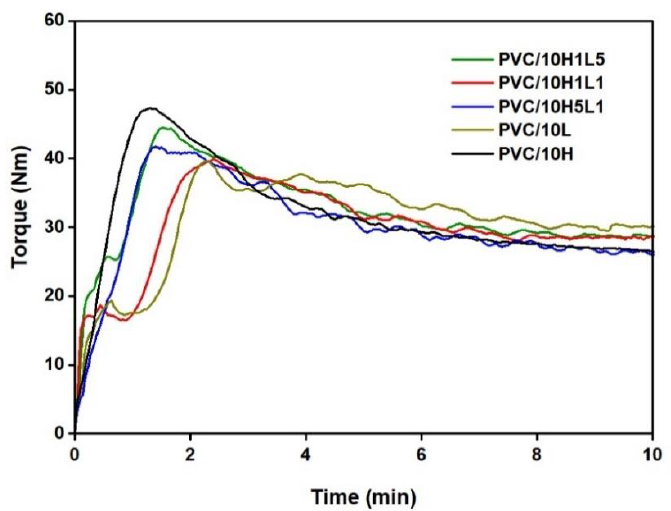
Figure 4. Torque vs. time of kneading for PVC and PVC composites with 10 wt% of fillers: lignin, halloysite and halloysite – lignin hybrids.